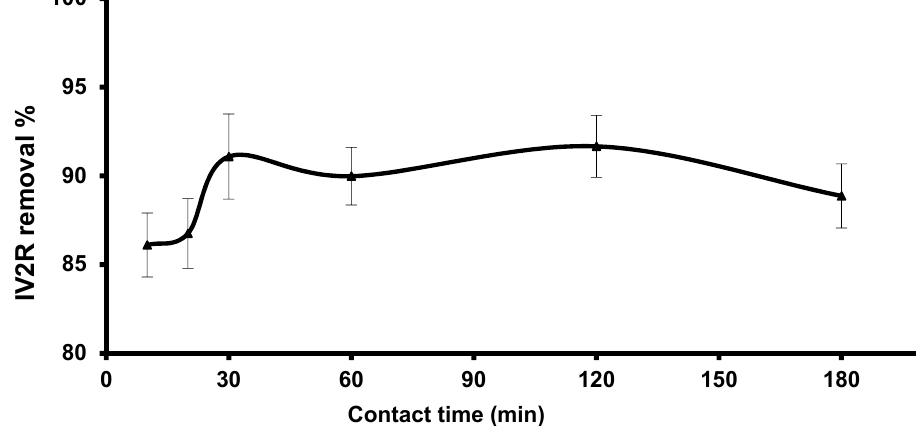
Figure 8. Influence of agitation time on the removal of IV2R.